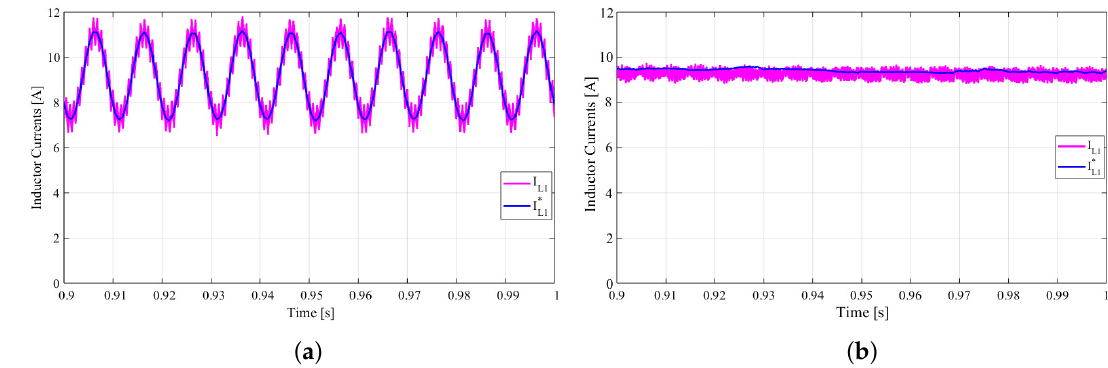
Figure 5. Reference and actual inductor currents when ( a ) 2 ω suppression is not activated, ( b ) 2 ω suppression is